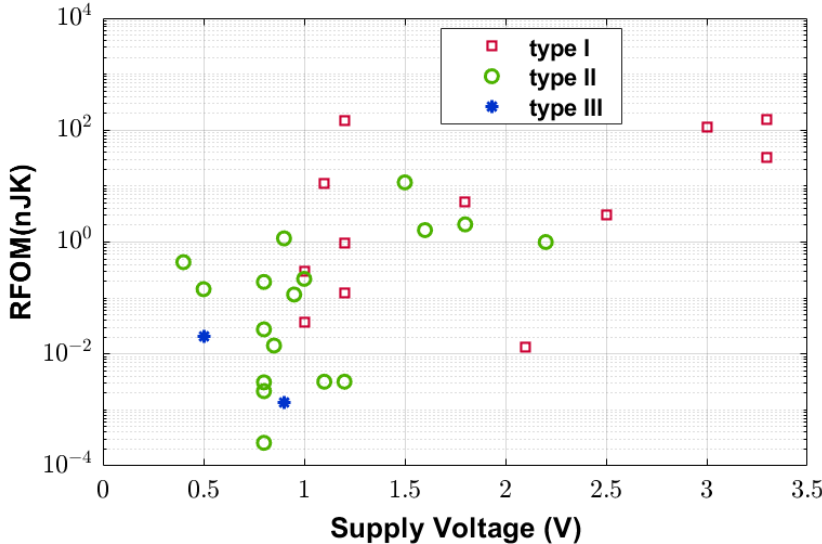
Figure 13. Resolution figure of merit (RFOM, log scale) versus the supply voltage for all three types of MOS-based temperature sensors.